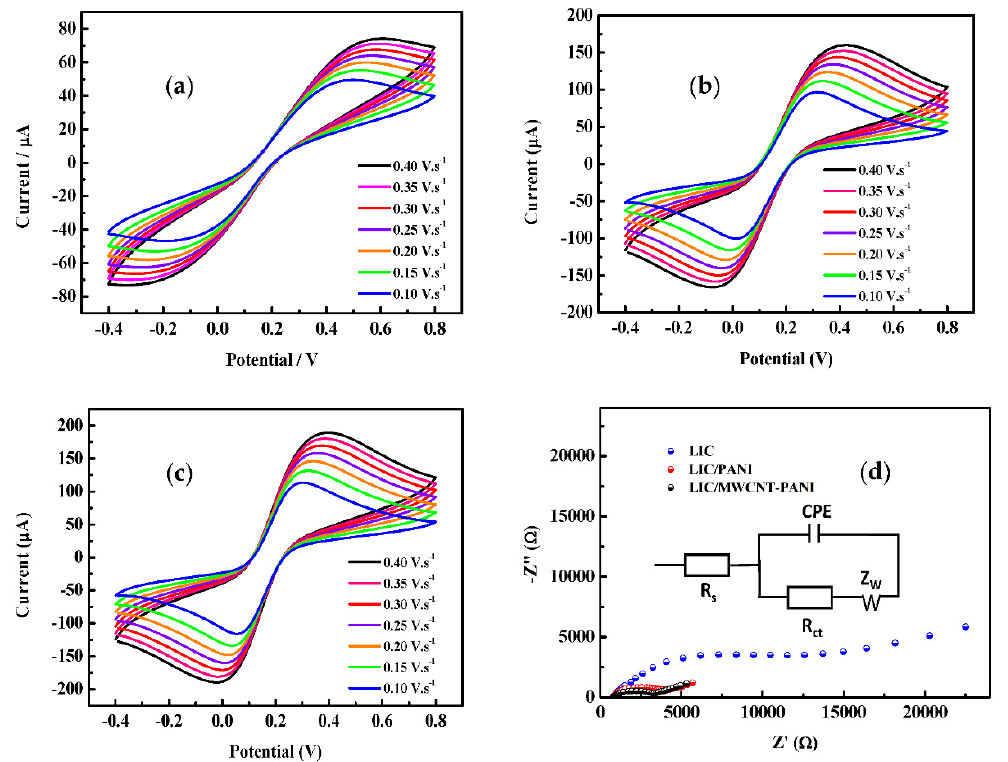
Figure 5. CVs of the prepared transducers, ( a ) LIC, ( b ) LIC/PANI and ( c ) LIC/MWCNT-PANI recorded at different scan rates from 100 to 400 mV · s − 1 in the presence of the redox mediators 5 mM [Fe(CN) 6 ] 3 − /4 − in 0.1 M KCl and ( d ) Nyquist plots of the bare LIC, LIC/PANI and LIC/MWCNT-PANI electrodes; inset: equivalent circuit.